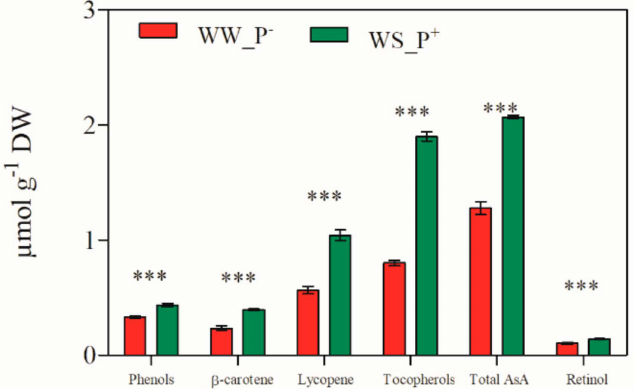
Figure 16. Antioxidant compounds in red ripe fruits of S. lycopersicum cv. Micro-Tom grown under well-watered conditions (WW_P − ) and water-stressed conditions coupled with root treatment with paramylon nanofibers (WS_P + ). Data are shown as mean ± SD. The significant di ff erences are for: *** P <